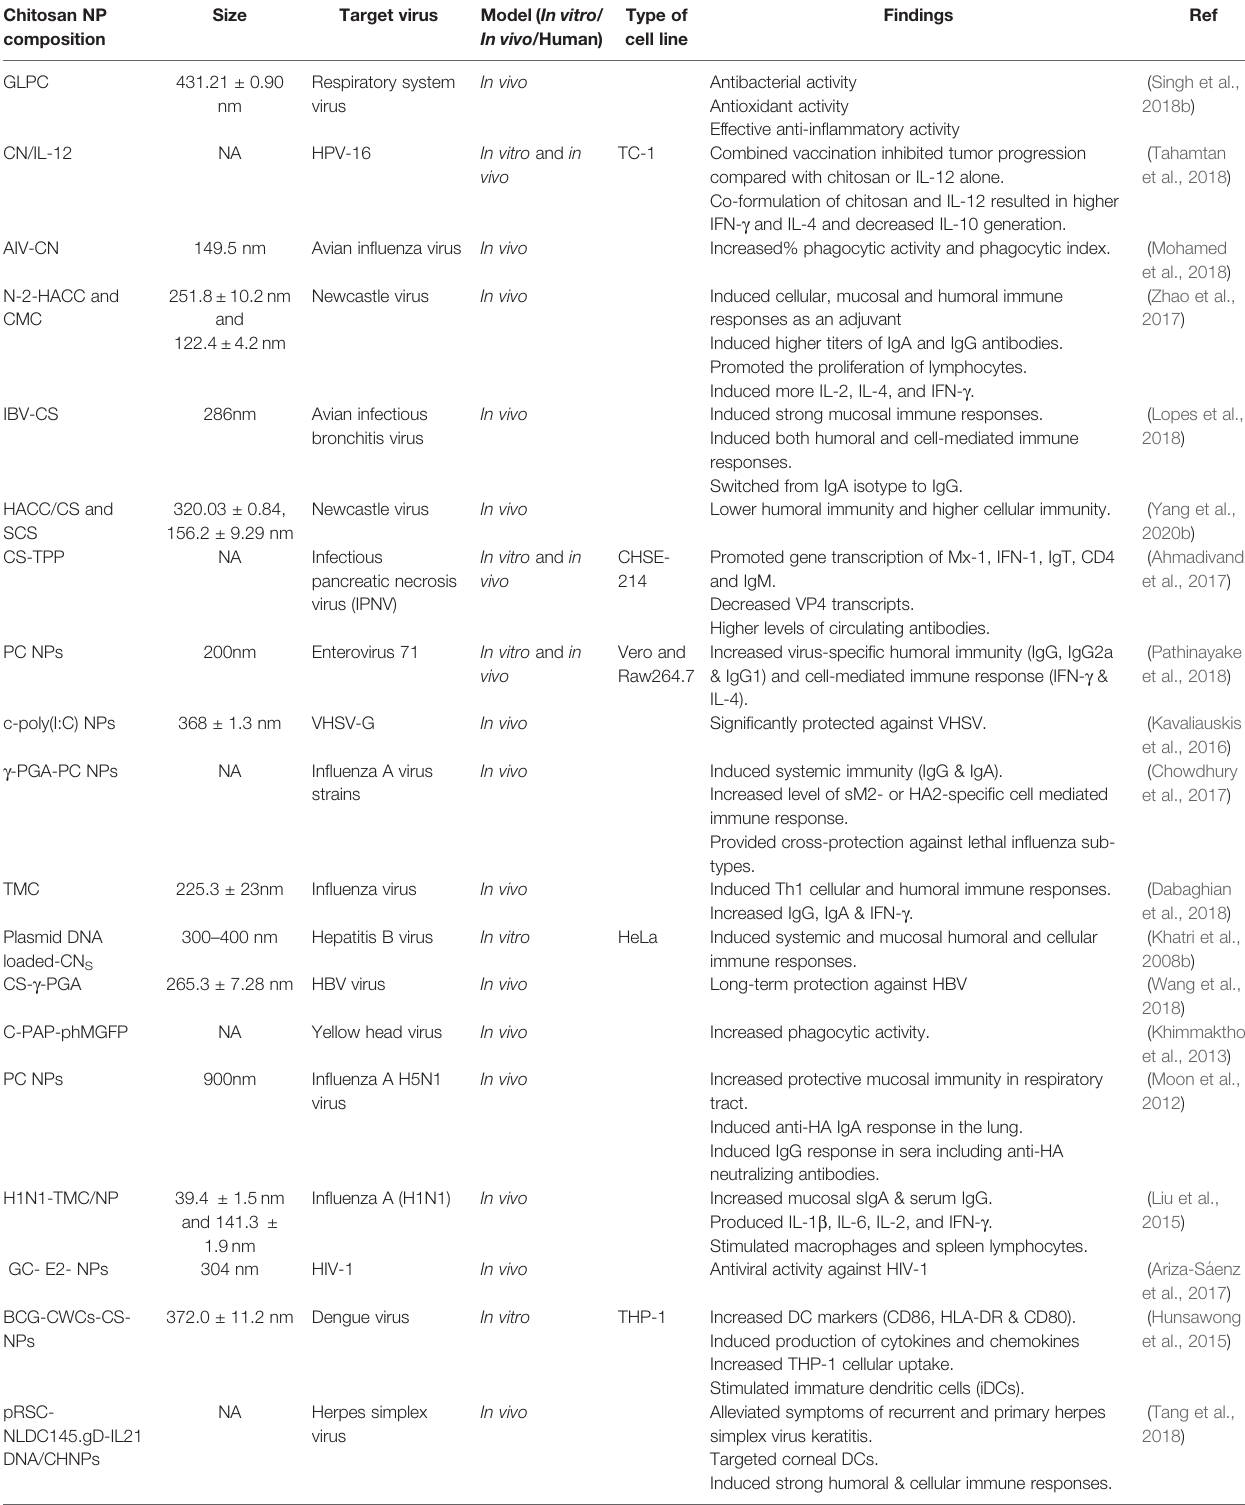
TABLE 2 | Chitosan nanoparticles investigated for vaccination against viral infections. Chitosan NP